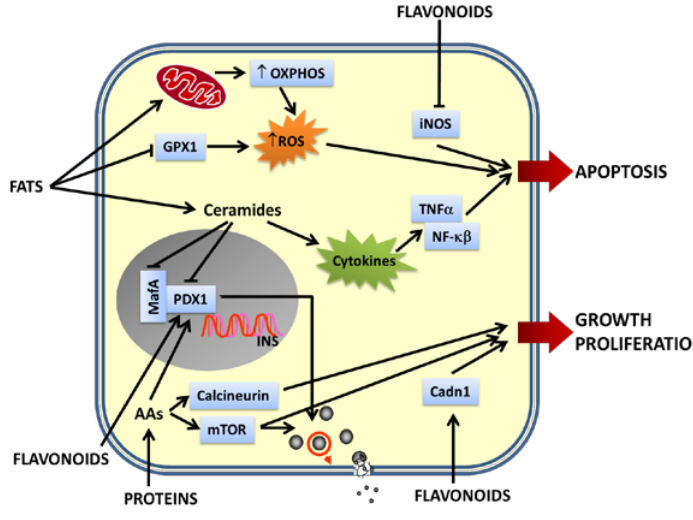
Figure 2. Effects of nutrients on β cell gene expression. Pancreatic β cells are able to sense dietary nutrients and respond to them releasing insulin. Different nutrients and their metabolites affect transcription of genes very important for maintenance of β cell function and integrity. Flavonoids upregulate the expression of genes involved in insulin synthesis, nutrient-induced insulin release and β cell proliferation and downregulate genes implicated in β cell apoptosis. Proteins positively regulate insulin synthesis, insulin release, β cell proliferation and growth upregulating the expression of mTOR, calcineurin and Pdx1. Fats upregulate OXPHOS genes leading to the generation of metabolic coupling factors critical for insulin exocytosis. On the other hand, a chronic exposure of β-cells to high levels of fats (mainly saturated fatty acids) induces excessive levels of ROS and pro-inflammatory cytokines, leading to an increased apoptosis. The upregulation of the expression of cytokine genes and genes involved in pro-inflammatory signaling pathways, together with the downregulation of genes implicated in the antioxidant defenses of β cells, contribute to β cell apoptosis. Moreover, chronic exposure to fats and their byproducts downregulate the expression of genes necessary for insulin synthesis, nutrient-induced insulin release, β cell integrity, maintenance and survival (Pdx1 and MafA). Impairment of β-cell function is a hallmark of pancreatic β-cell failure and may lead to development of